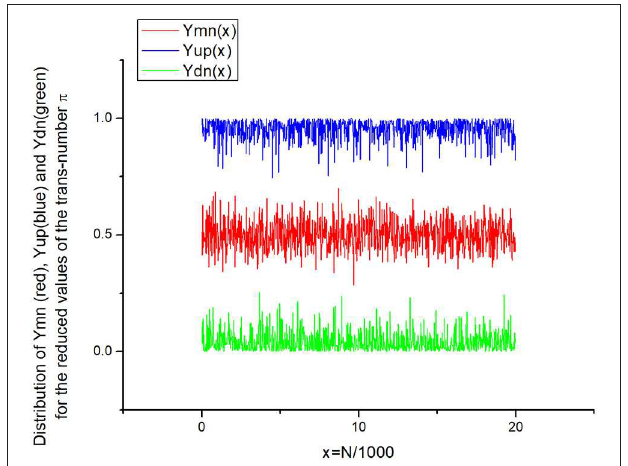
FIGURE 1 | Three distributions of the “ideal” noise obtained for the transcendental number π . They are compressed by the factor b = 20 and contain only 1,000 data points. They form three initial random sequences that can be transformed into three 3D-surfaces for identification of their differences and formation of a specific “fingerprint”.